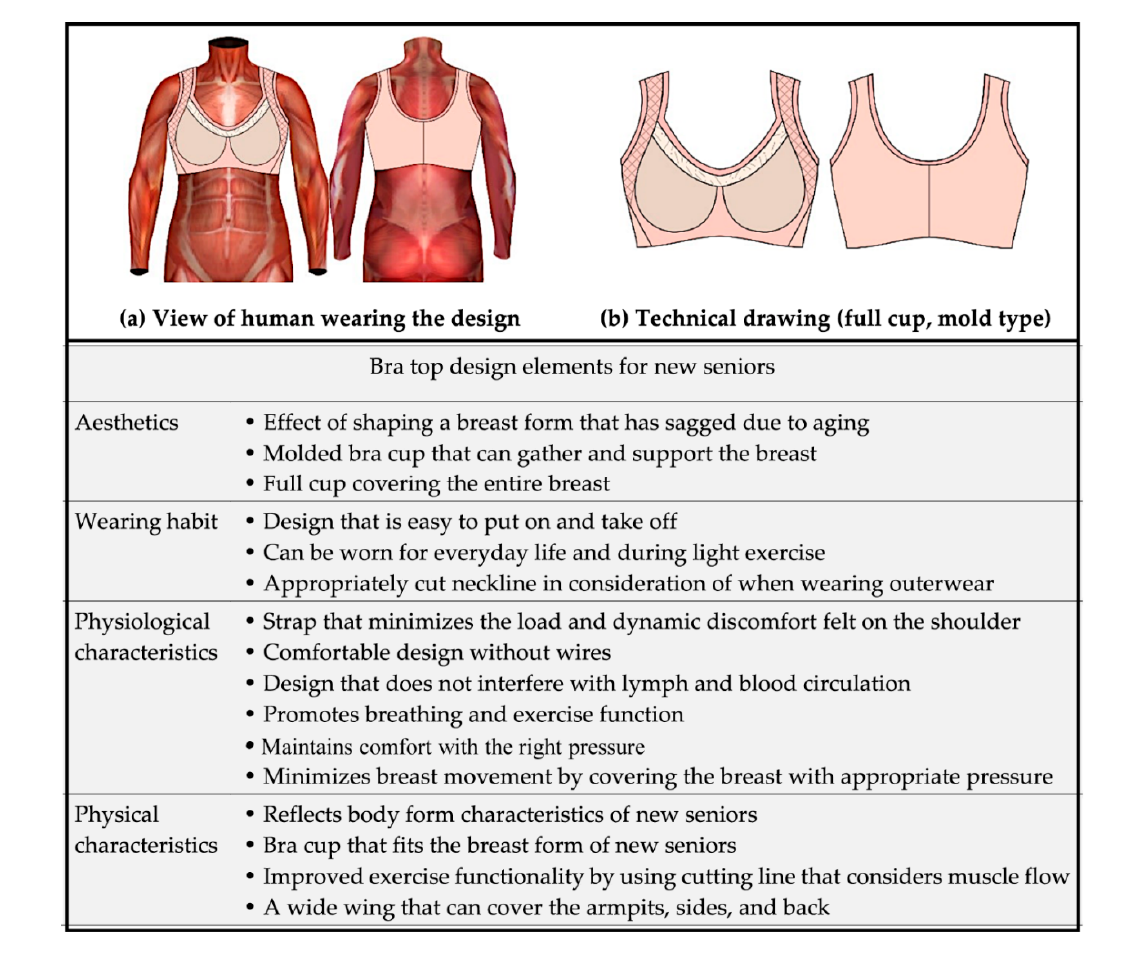
Table 1. Human body dimensions of the target group (size 80A) (Unit: mm, kg, °). Category